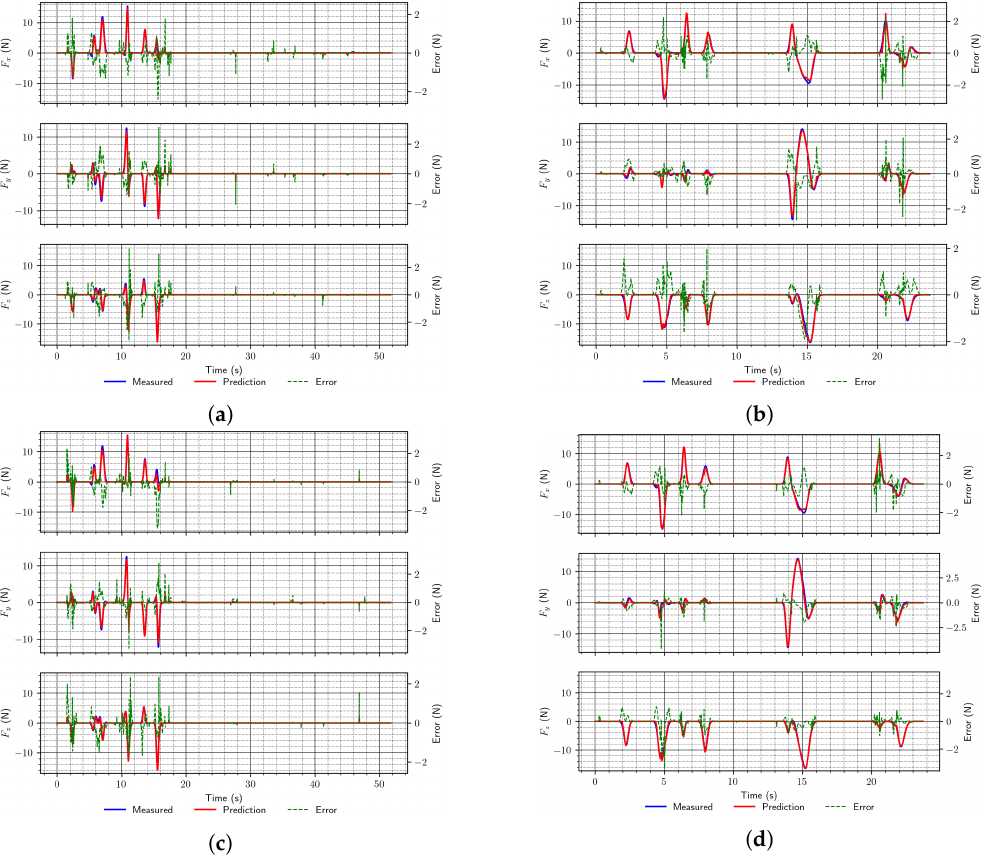
Figure 6. Examples of end-effector force predictions using the simulation data test set for optimized LSTM architectures. ( a ) Optimized LSTM (arch. #10); ( b ) optimized LSTM (arch. #10); ( c ) optimized LSTM (arch. #11); ( d ) optimized LSTM (arch.